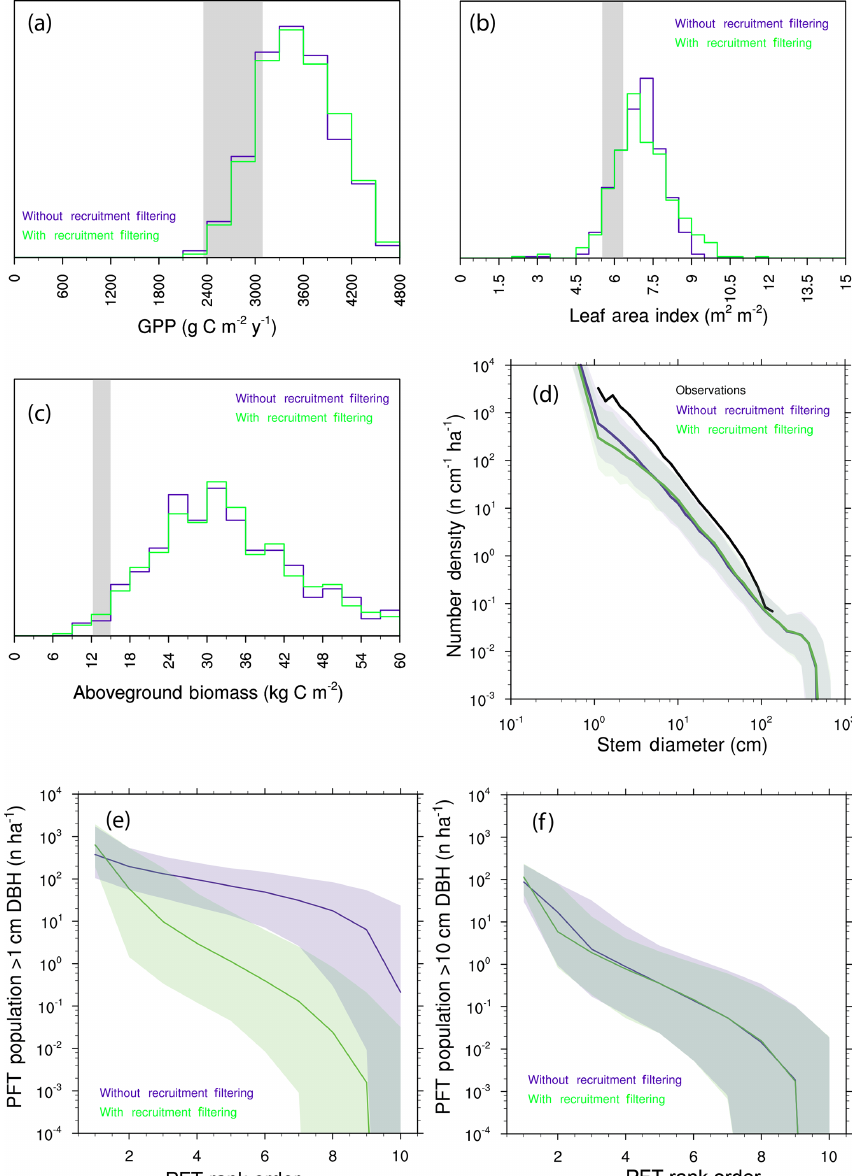
Figure 11. Predictions from 10-PFT ensembles with and without recruitment filtering. (a–c) Histograms of mean GPP (a) , LAI (b) , and aboveground biomass (c) . Observational range shown as grey band in (a) – (c) . (d) Size distributions of ensembles. (e–f) Rank abundance curves for PFTs. (e) PFT abundances for all trees greater than 1cm diameter (DBH – diameter at breast height). (f) PFT abundances for all trees greater than 10cm diameter. For all cases in (e) – (f) , solid line is the median ensemble member, and shaded range is the 5th–95th percentiles across 576